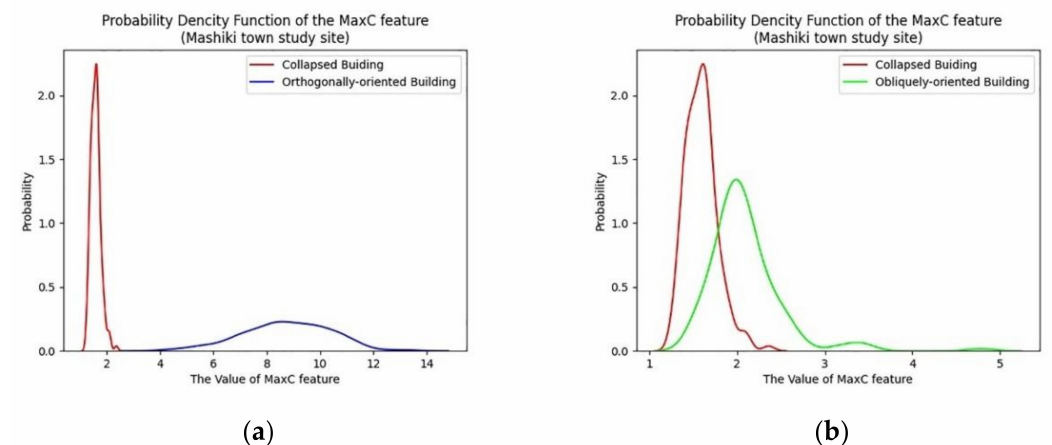
Figure 23. The pdfs of the MaxC feature in the Mashiki town study site: ( a ) pdfs of collapsed buildings and orthogonally- oriented buildings; ( b ) pdfs of collapsed buildings and obliquely-oriented